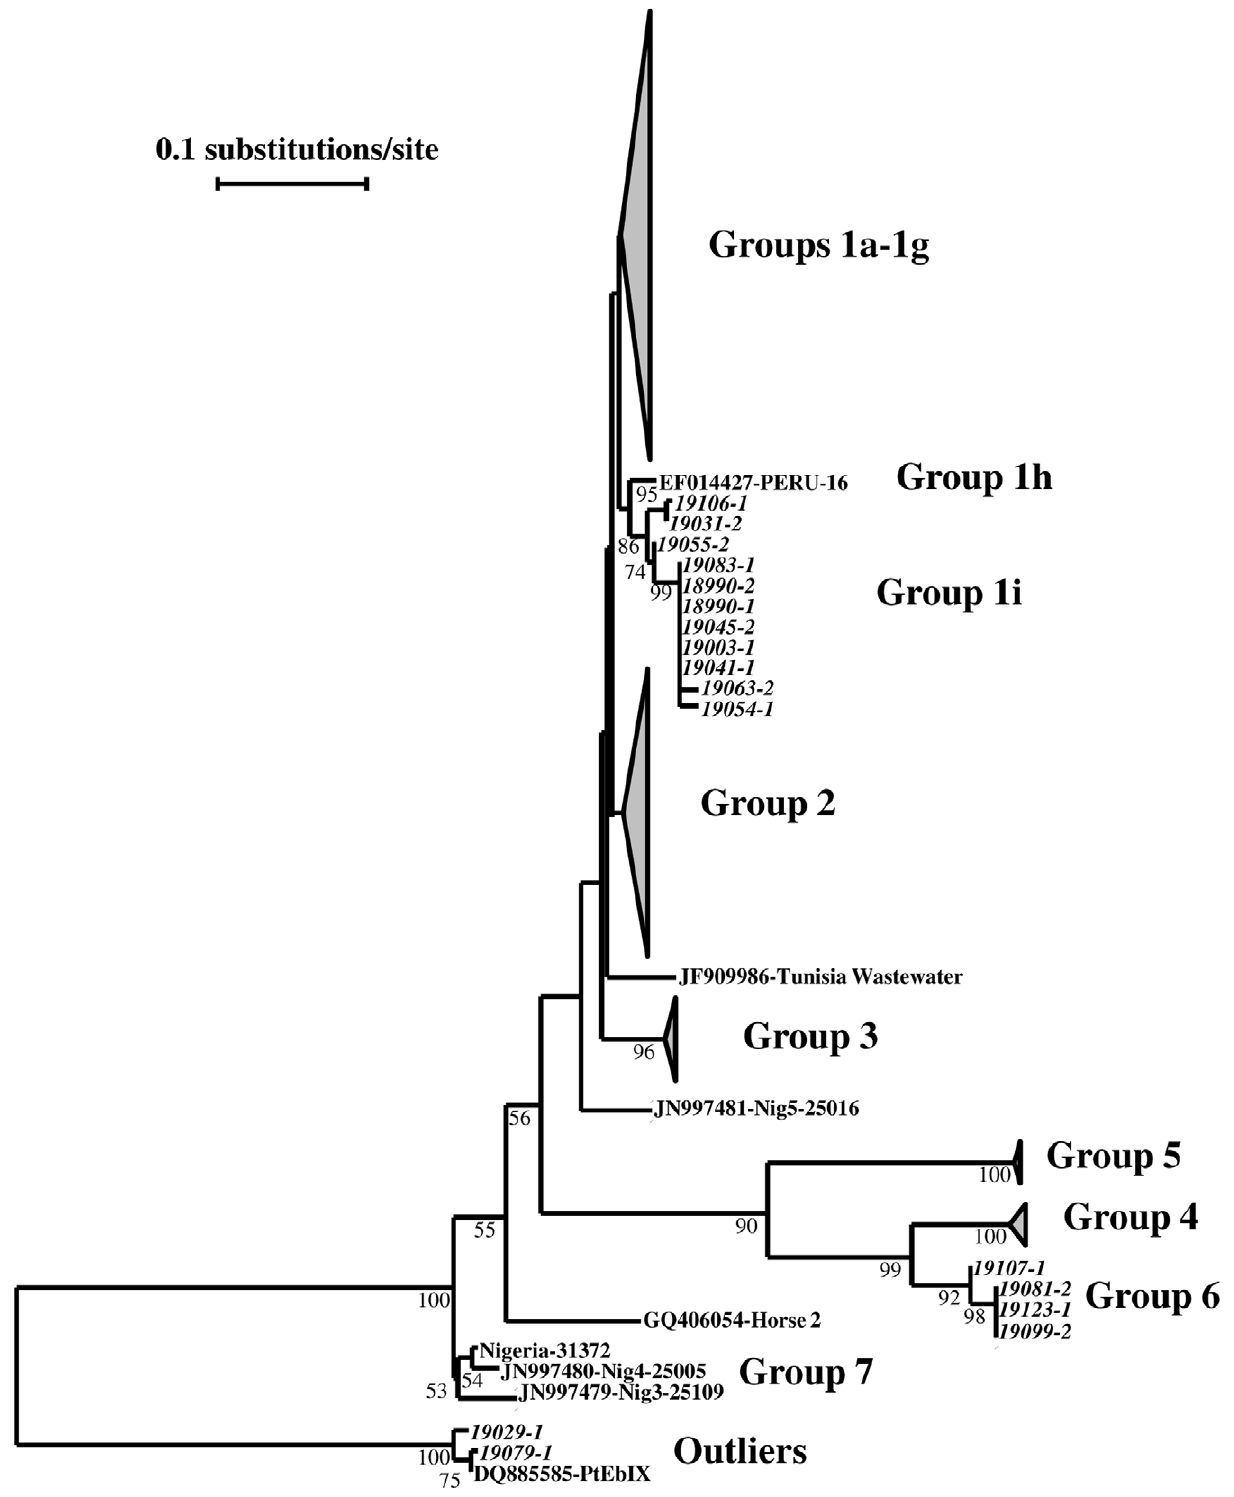
Figure 1. Phylogenetic relationship of Enterocytozoonbieneusi genotype groups. The relationship of new E. bieneusi genotype groups (1i and 6) identified in this study to established E. bieneusi genotype groups was inferred by a neighbor-joining analysis of nucleotide sequences of the ITS, based on Kimura 2-parameter distances. Some sequences generated in the study are italicized, while the remaining 538 sequences in Groups 1a– 1g and one sequence in Group 3 are not shown (see Table 3). Several unique ITS sequences from AIDS patients in a recent Nigerian study [43] are designed as Group 7.